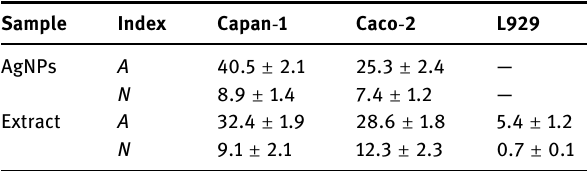
Table 1: Apoptotic index ( A ) and necrotic index ( N ) of AgNPs